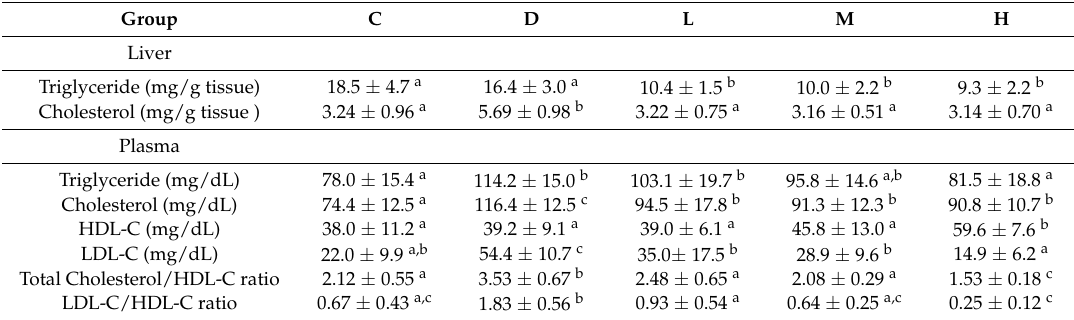
Table 5. Liver and plasma lipids after the six-week melatonin intervention.